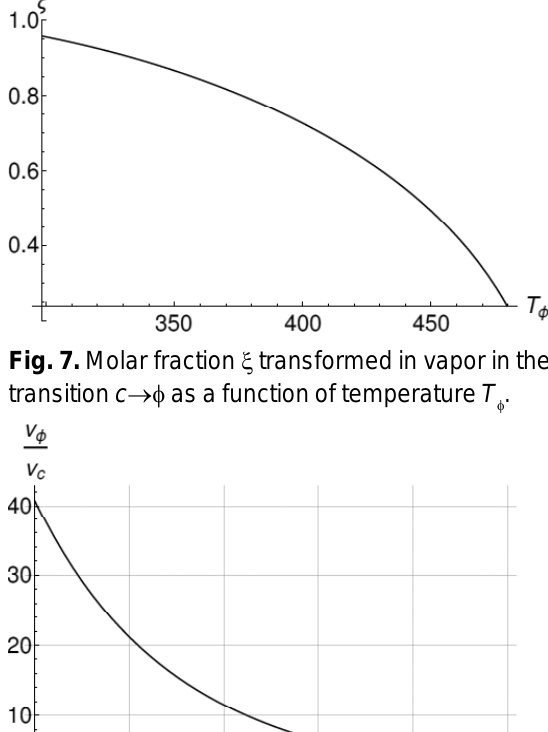
Fig. 8. Ratio of volume v temperature T